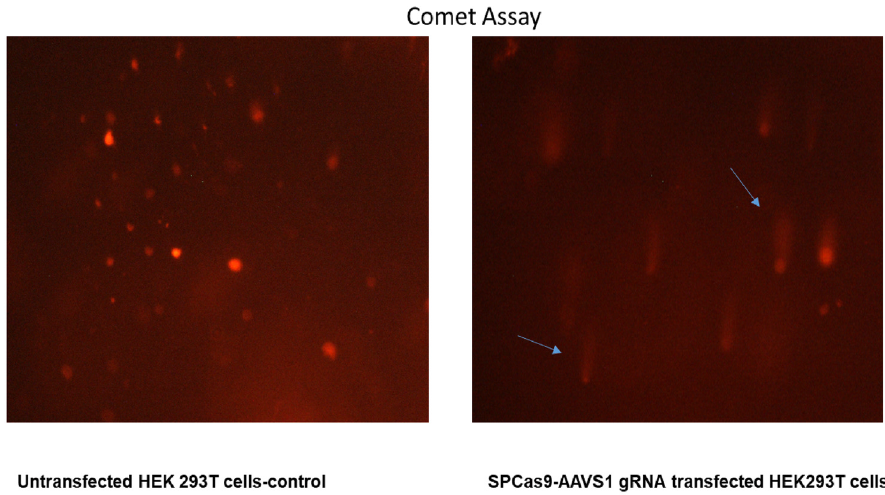
Figure 5. Cas9-sgRNA cause DNA damage, revealed by a Comet assay. The untreated cells have intact round/oval nuclei while the Cas9-sgRNA treated cells shows a comet shaped nucleus because of DNA damage.